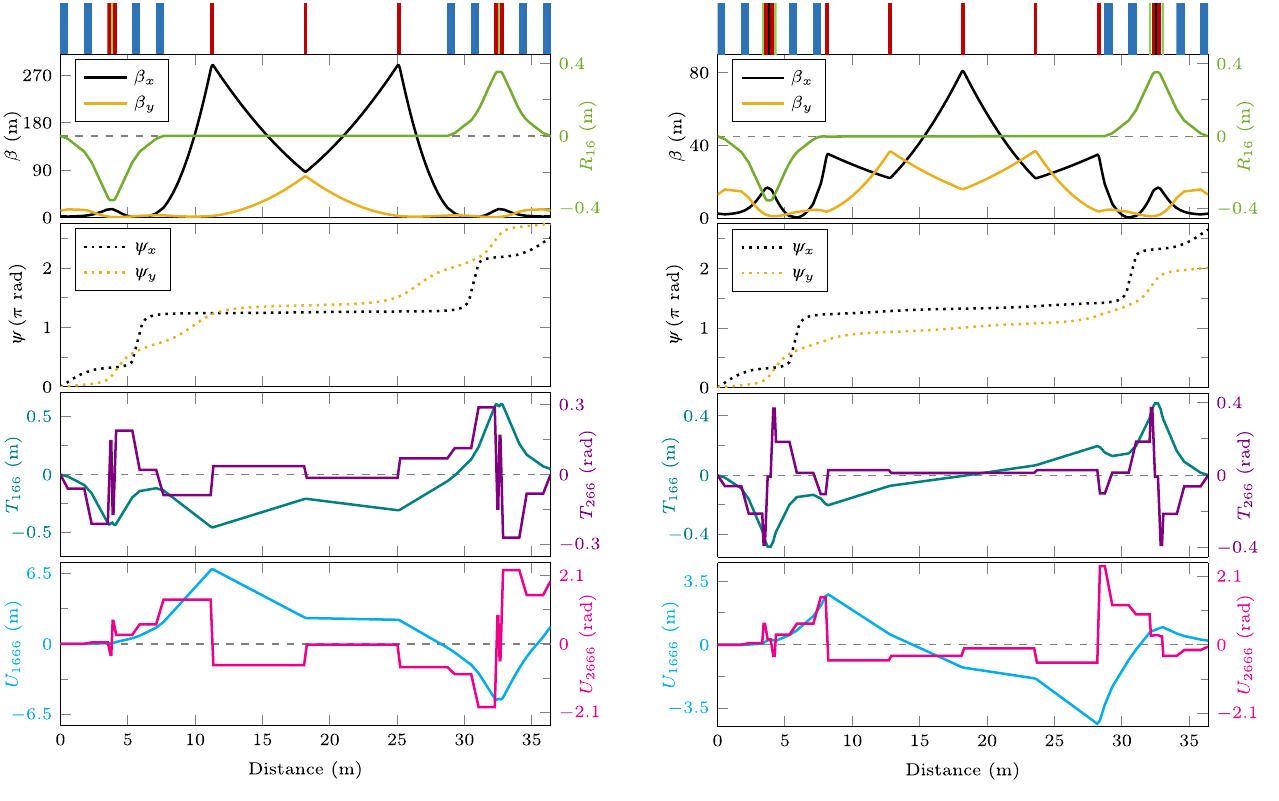
FIG. 3. Original BC2 layout (top) followed by beta functions ( β x and β y ) and dispersion ( R 16 ), betatron phase advances ( ψ x and ψ y ), second-order spatial and angular dispersion ( and finally third-order spatial and angular dispersion ( U 1666 and U 2666 ). Note the asymmetric behavior of the higher-order dispersion curves.